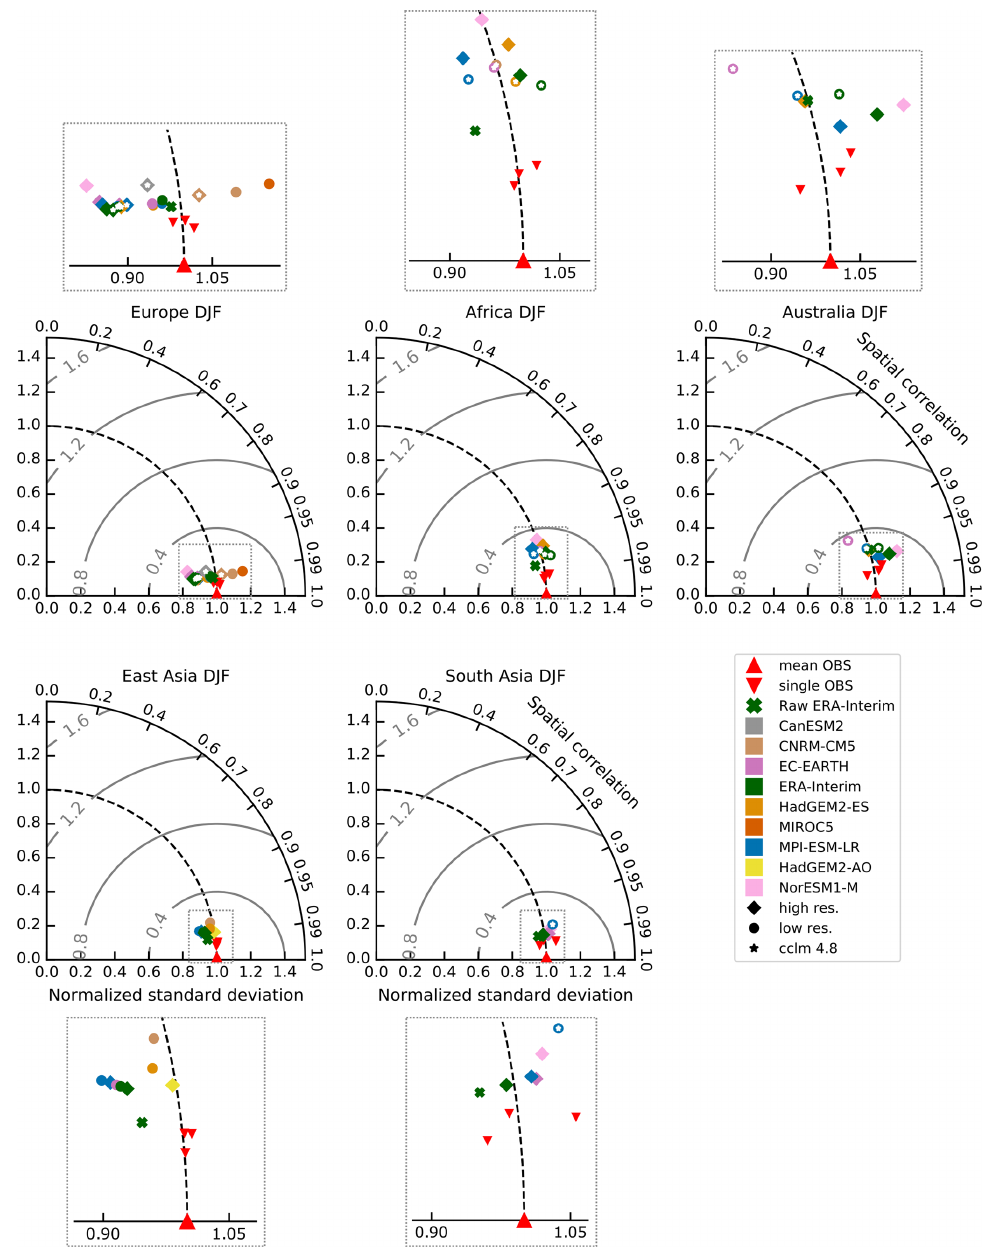
Figure 5. Spatial Taylor diagrams exploring the ERA-Interim- and GCM-driven simulations for DJF air temperature where only land points are included for the domains Europe, Africa, East Asia, Australasia, and South Asia. The colors indicate the forcing data, and the diamond (circle) represents the 12km or 24km, respectively (50km), simulations. The older model version is marked with a small white star within the colored data points. All the different simulations are listed in Table S1. The triangle is the ensemble mean of all the observations, while the upside triangles represent each single observation dataset. The raw ERA-Interim reanalysis is included as a green cross. Zoomed results indicated by the boxes are shown at the top and bottom of the respective